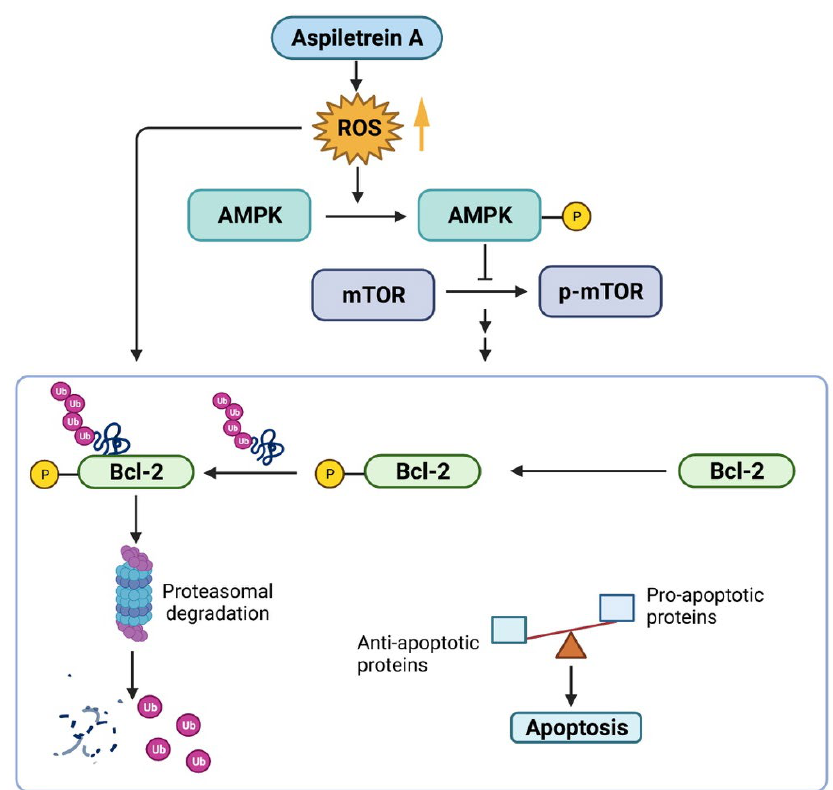
Figure 8. Schematic of the molecular mechanism of aspiletrein A (AA) treatment on lung cancer apoptosis. AA activates AMPK by triggering the generation of ROS, which subsequently suppresses activation of p-mTOR activation and increases levels of phosphorylated Bcl-2. This facilitates Bcl-2 ubiquitination and degradation through a proteasomal mechanism. ROS mediated by AA also directly participated in the Bcl-2 degradation. As a result, antiapoptotic Bcl-2 was downregulated, causing an imbalance of cell survival and cell death signals and thereby favoring cell apoptosis.